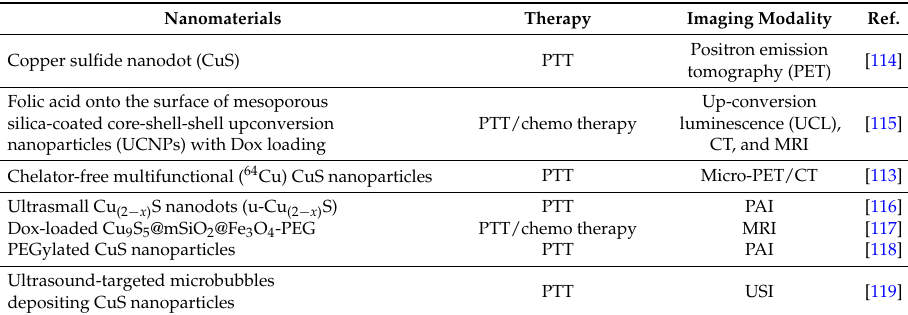
Table 2. Therapeutic and imaging potential of CuS